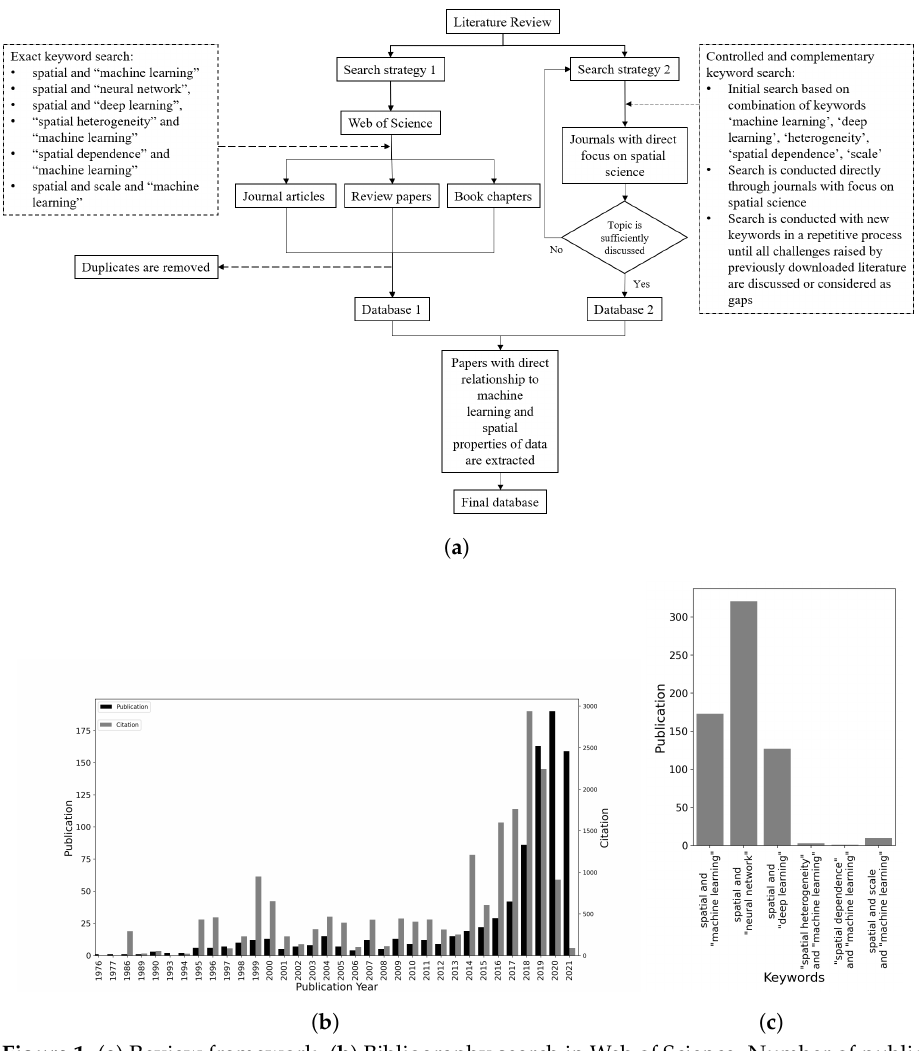
Figure 1. ( a ) Review framework. ( b ) Bibliography search in Web of Science. Number of publications and citations by year. ( c ) Bibliography search in Web of Science. Number of publications by